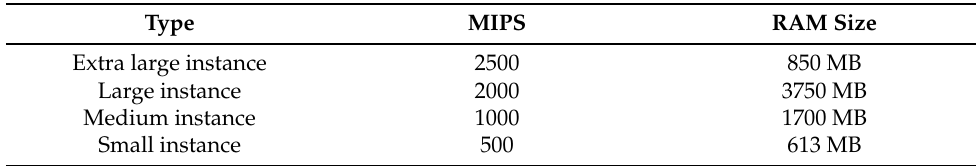
Table 2. Amazon EC2 virtual machine